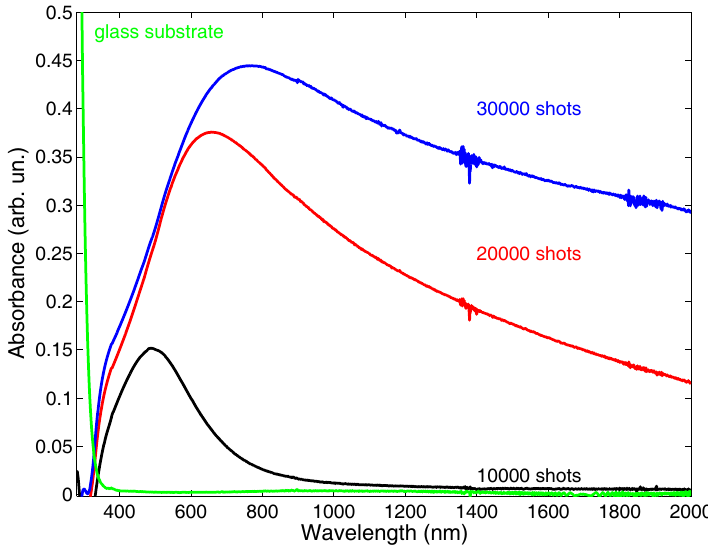
Figure 4. UV-Vis absorption spectra of Ag samples deposited at 70 Pa of Ar with di ff erent numbers of laser